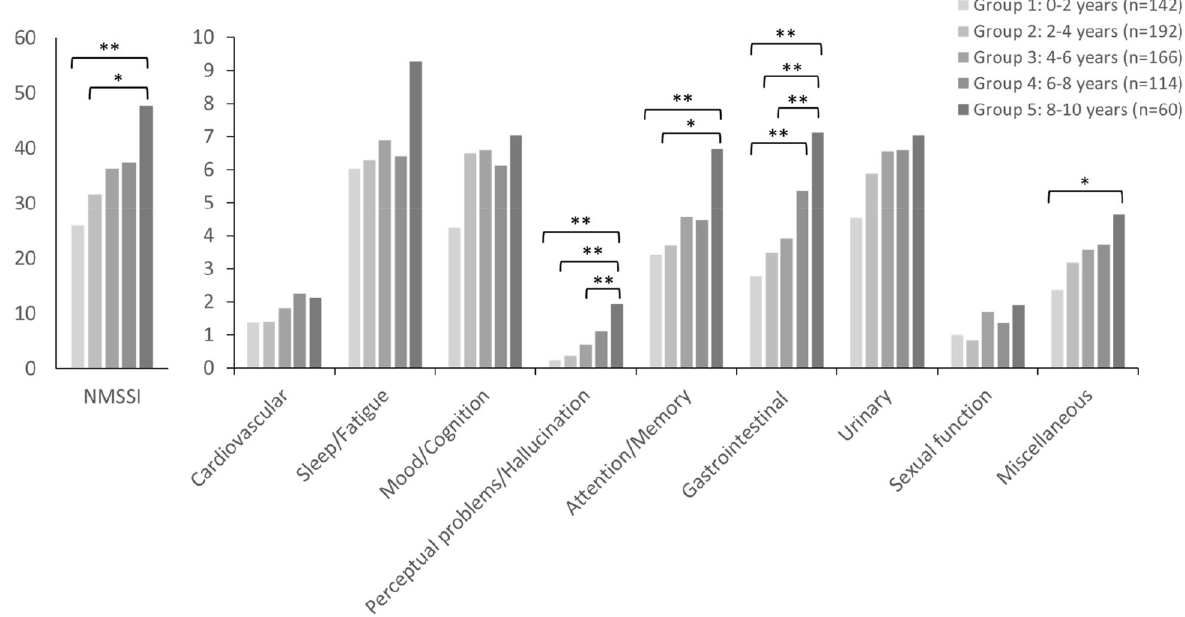
Figure 2. The post hoc analysis of Table 2. We only showed the significance of the comparison to group 1 to focus on the early evolution. The left figure is the total score of NMS scale and the right figure is the score of each domain. *p < 0.05; **p < 0.01.